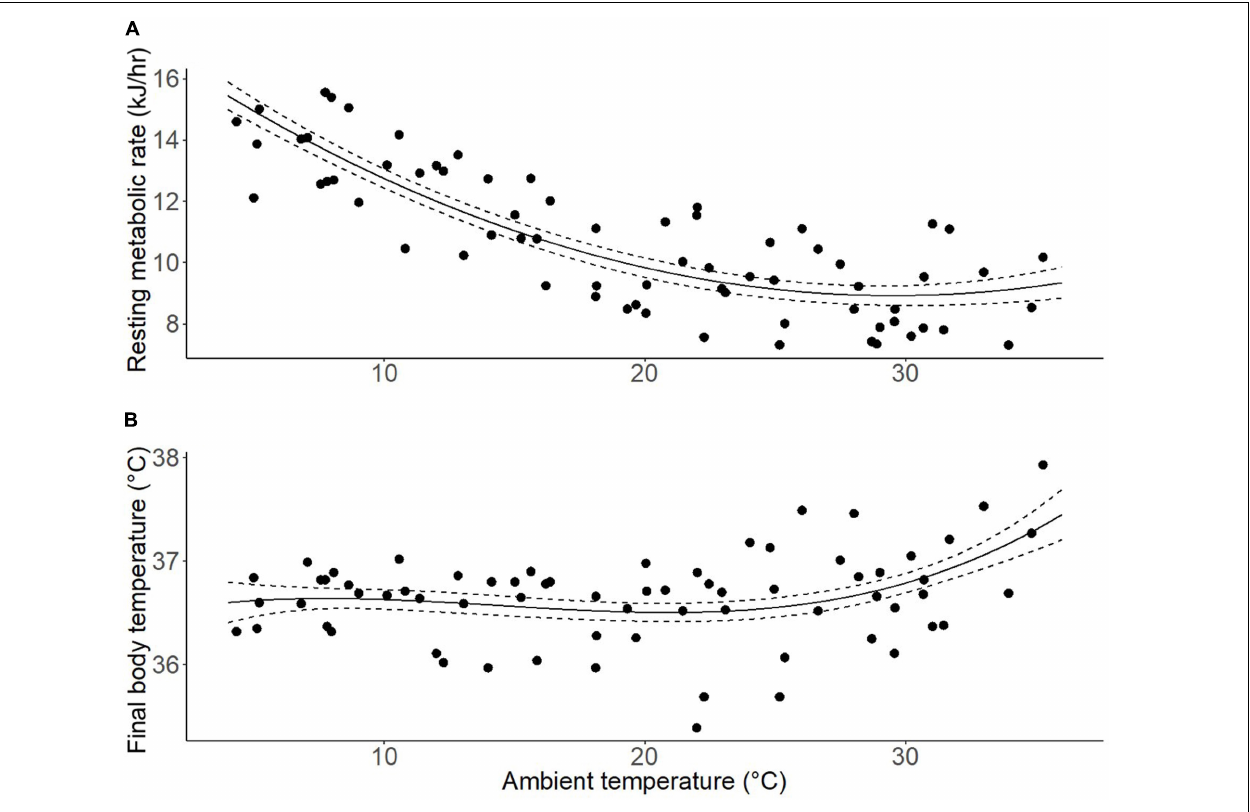
FIGURE 1 | The relationship between ambient temperature and (A) resting metabolic rate (RMR), and (B) body temperature of ringtail possums ( n = 12) at temperatures between 4 and 35 ◦ C. The solid lines are the best fit from the statistical model, with standard error (dashed lines); points are individual measurements.